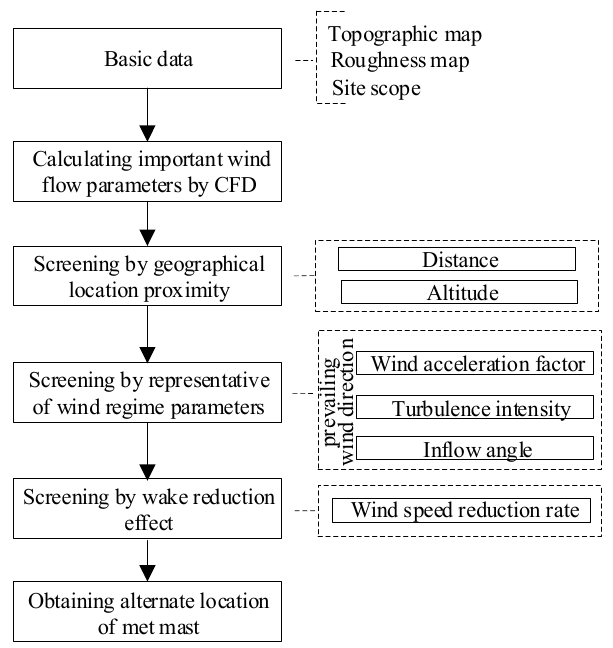
Figure 2. Location screening process of alternative met mast.